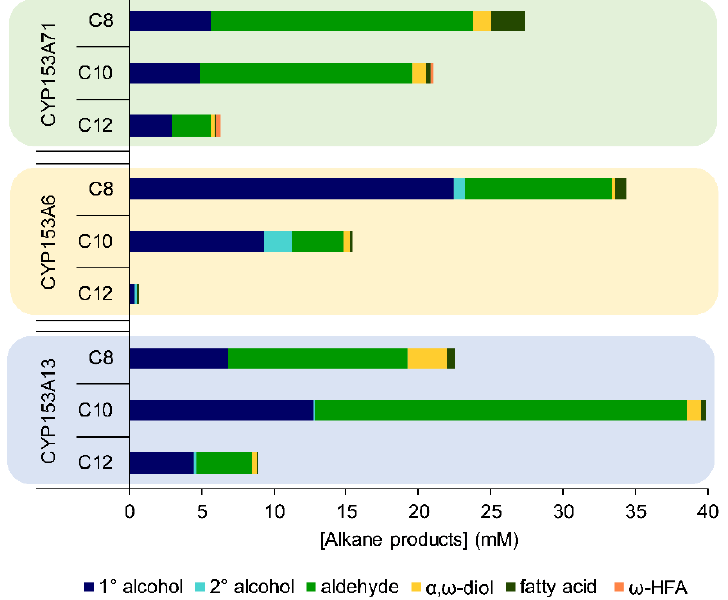
Figure 3. Comparative biotransformations of C8–C12 n -alkanes by CYP153A71, CYP153A6, and CYP153A13. Results are averages from two independent experiments, each with three biological replicates. n -alkanes added as a second phase (250 µL).